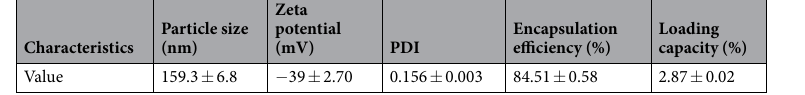
Table 1. Characteristics of curcumin liposomes.